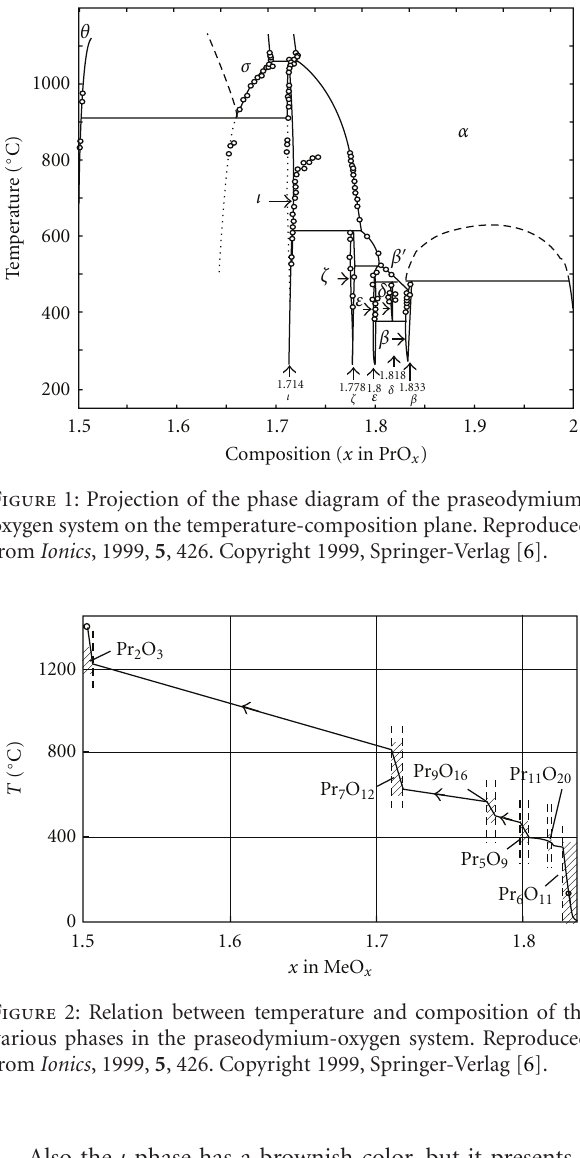
Also the ι phase has a brownish color, but it presents a rhombohedral lattice with parameters a = 5 . 510 ˚A and α slightly less than 90 ◦ . The θ phase has a similar lattice (being hexagonal : side of the base hexagon = 3.859 ˚A, height of the prism = 6.008 ˚A) but a di ff erent color, being